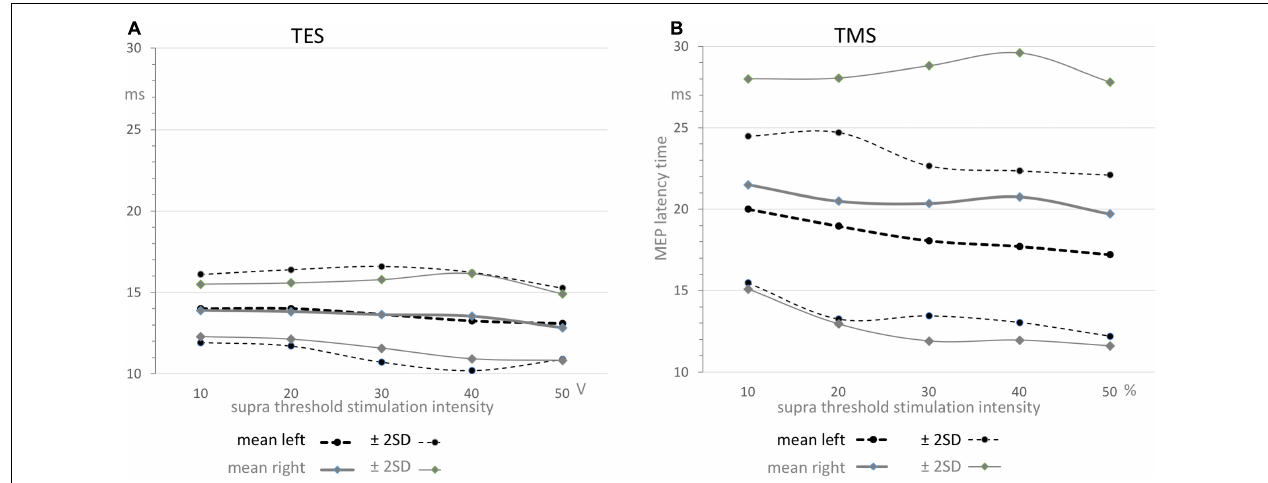
FIGURE 4 | Functions of means ± 2SD confidence intervals of MEP latency times as function of supra threshold transcranial stimulation for TES (A) and TMS (B) . The graphs depicted in panel A reflect the relative narrow region between 11 and 16 ms which can solely be allocated to the direct conduction route as also illustrated by the narrow distribution functions for TES in Figure 3 , while the graphs depicted in panel B illustrate the widely scattered results from TMS leading to 5–7 ms higher mean values and over 3 times widened ± 2SD confidence interval. Note that the graphs in panel A show nearby equal means while in contrast, the graphs in panel B show significant different means for TMS between left and right sides with wide confidence intervals that vary between 12 and 29 ms. The values are summarized in Table 2 . All means show a gradual decrease by about –1.5 ms from 10 to 50 V for TES in panel A and about –2.5 ms for the left and –1.8 ms for the right side for TMS in panel